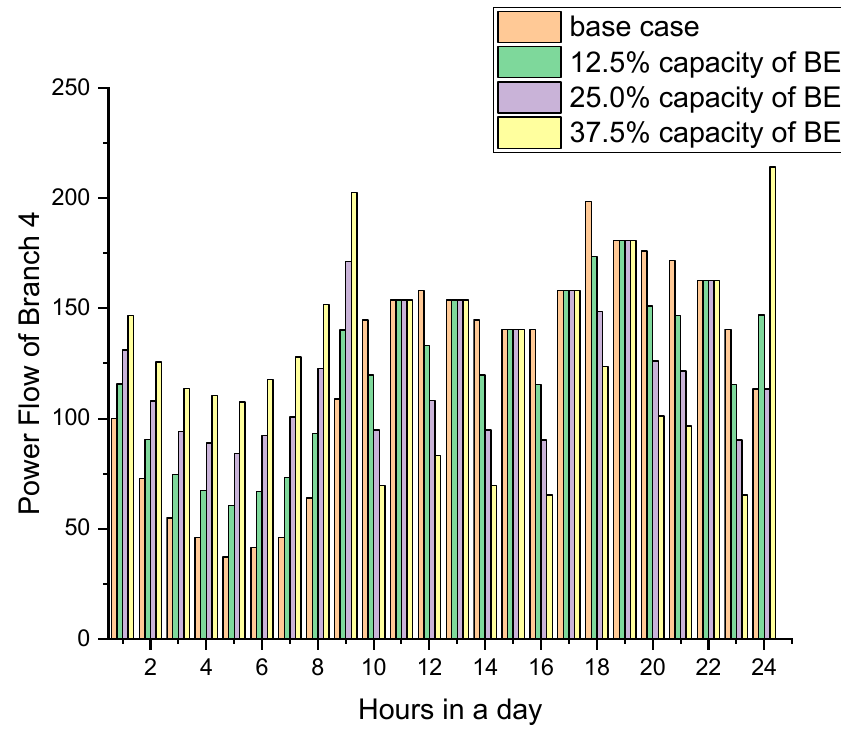
Figure 7. GenCo 3 Commitment.